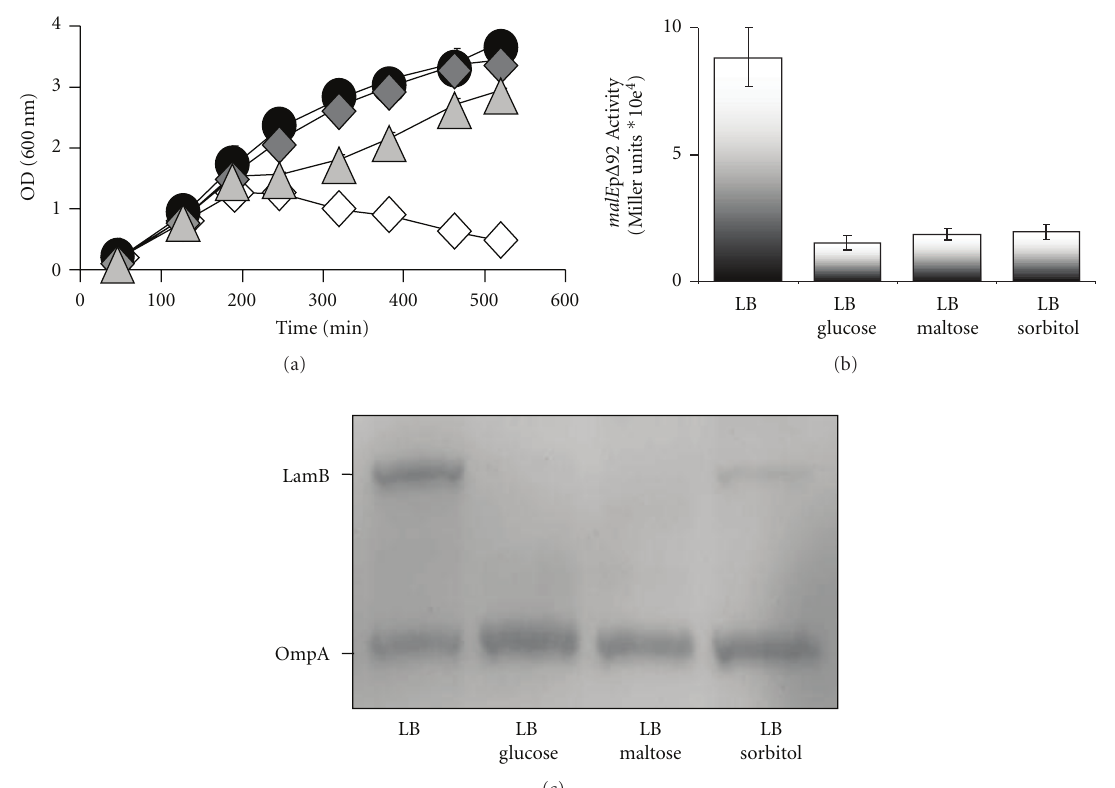
Figure 2: E ff ect of carbon sources on viability, mal gene transcription and LamB expression. (a) Growth curves of ompR malT con mutants (strain AJW3098) grown in LB at 37 ◦ C without sugars (white diamonds) or supplemented with 22 mM glucose (black circles), maltose (medium gray diamonds), or sorbitol (light gray triangles). Values represent the mean of triplicates. Error bars are only shown when greater than the symbol. (b) E ff ect of glycolytic carbon sources on mal gene transcription. β -galactoside activity was determined in ompR malT con mutants (strain AJW3098) carrying a malE p Δ 92- lac reporter fusion. Cells were grown in LB without carbon source or LB supplemented with 22mM glucose, maltose, or sorbitol. Cells were harvested at an OD 600 of 1. Values represent the mean of triplicates. (c) E ff ect of glycolytic carbon sources on LamB expression. Addition of carbon sources reduces LamB levels in ompR malT con mutants as determined by outer membrane preparations. Cells were grown in LB at 37 ◦ C and harvested during late exponential phase. Gels were stained with Coomassie brilliant blue. Lane 1, LB no additional carbon source (LB); lane 2, LB 22mM glucose (LB glucose); lane 3, LB 22mM maltose (LB maltose); lane 4, LB 22 mM sorbitol (LB